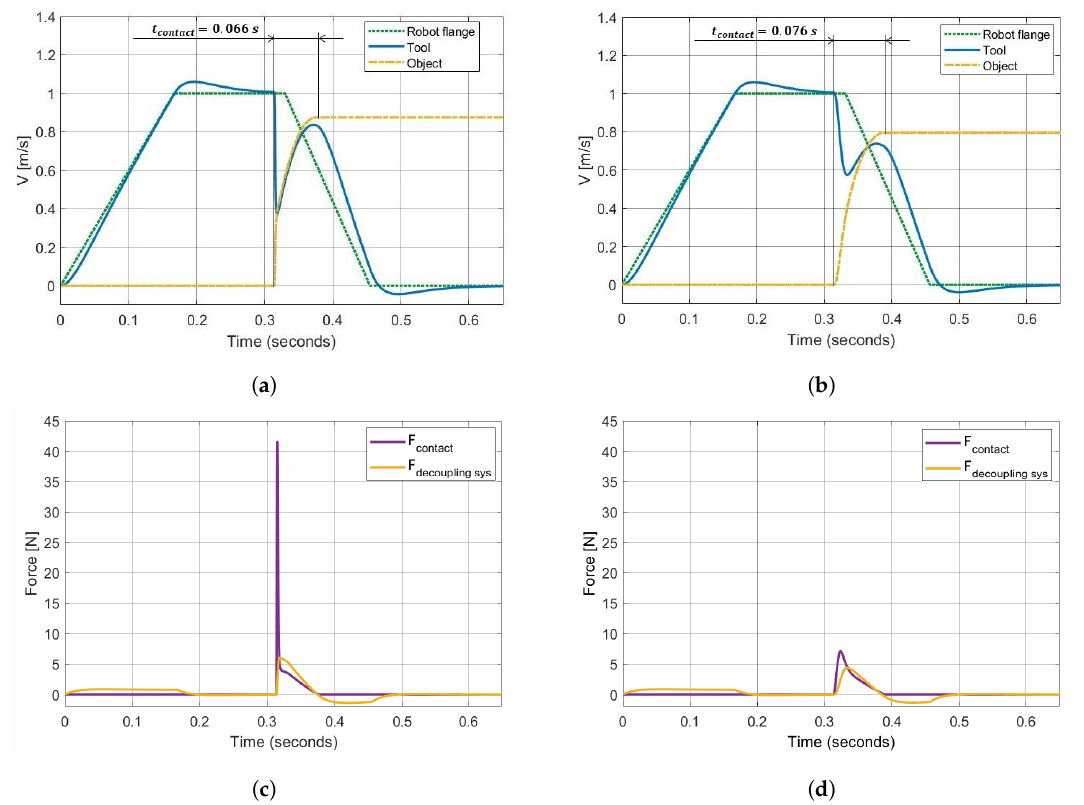
Figure 19. Velocity comparison: ( a ) k c = 10 5 N generated by the decoupling elements: ( c ) k c = 10 5 N